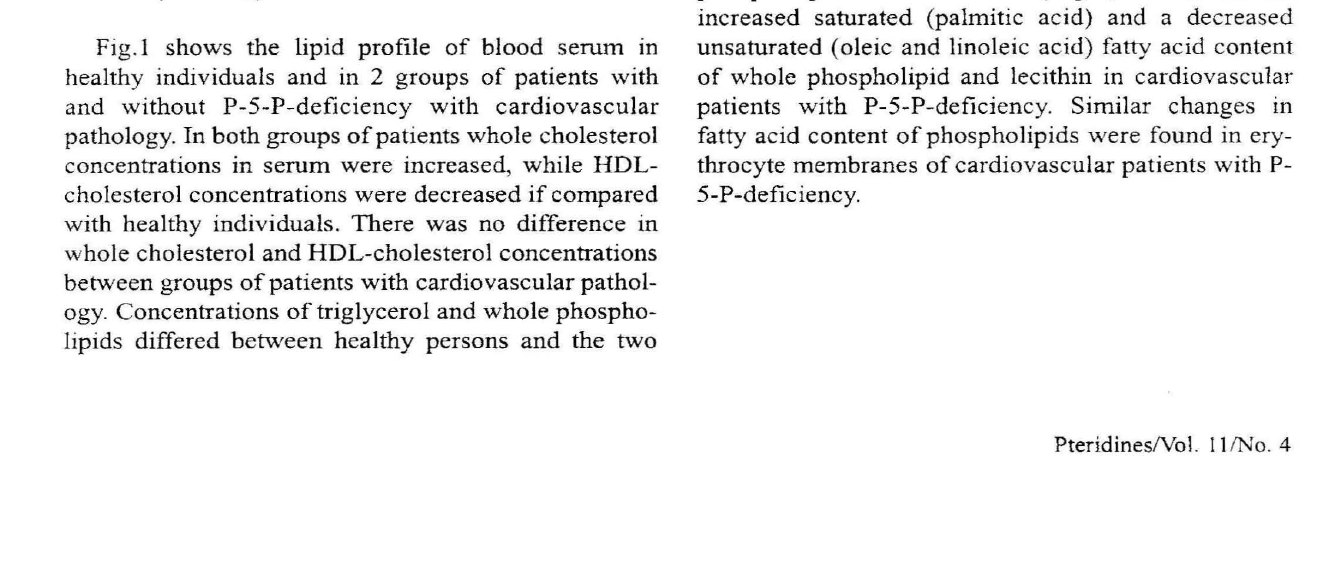
Fig.I. Concentrations (mean ± SO) of blood serum cholesterol, HDL-cholesterol, triglycerol and phospho lipids in healthy individuals (open bars) as well as in cardiovascular patients without P-5-P-deficiency (dot ted bars) and cardiovascular patients with P-S-P-defi ciency (hatched bars); the difference is statistically sig nificant (P < O.OS).